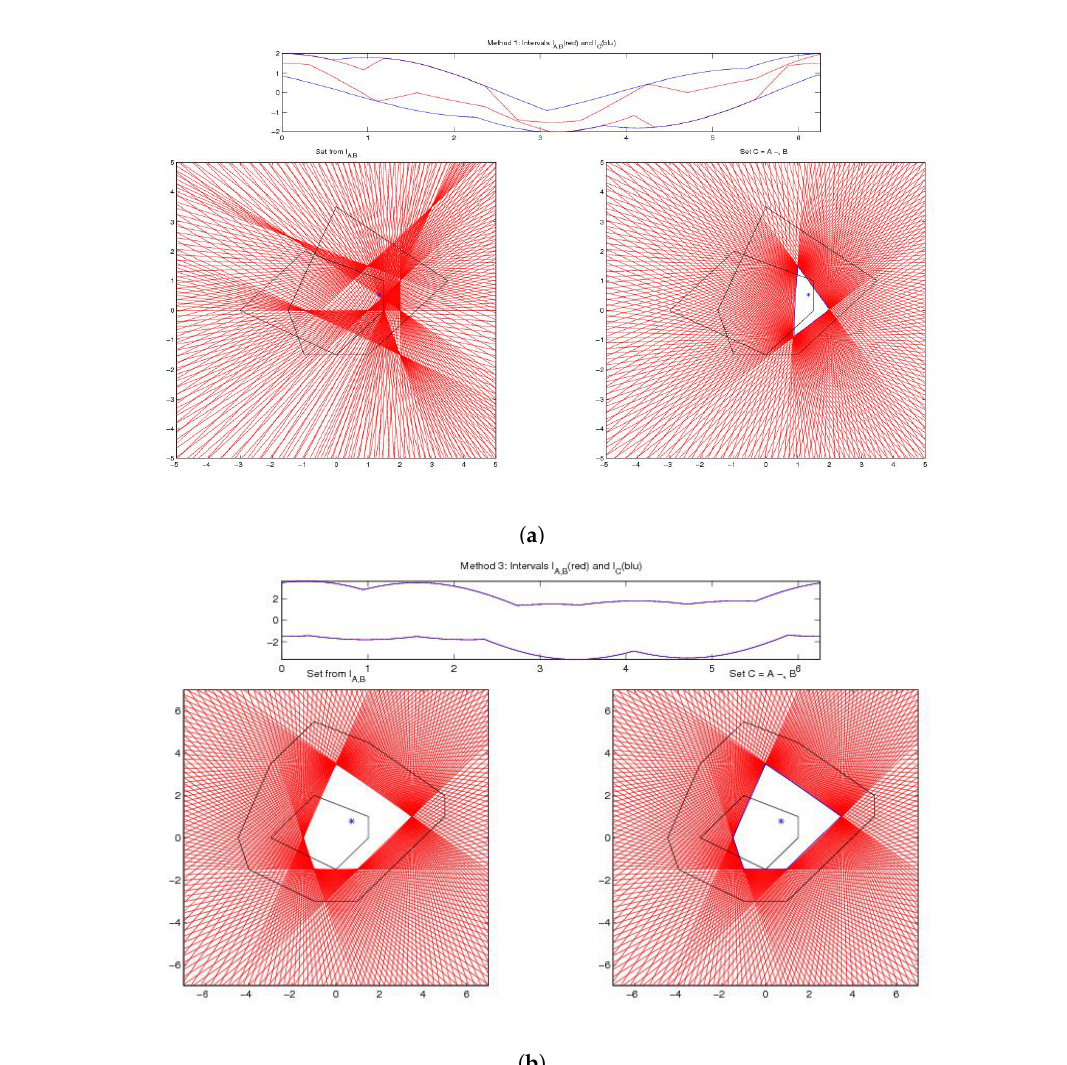
Figure 3. Example 3. g ∗ -difference C ∗ = A (cid:9) ∗ B a , µ for ( a ) top: A = A (cid:48) , B = B (cid:48) , ( b ) bottom: A = A (cid:48) + B (cid:48) , B = B (cid:48)